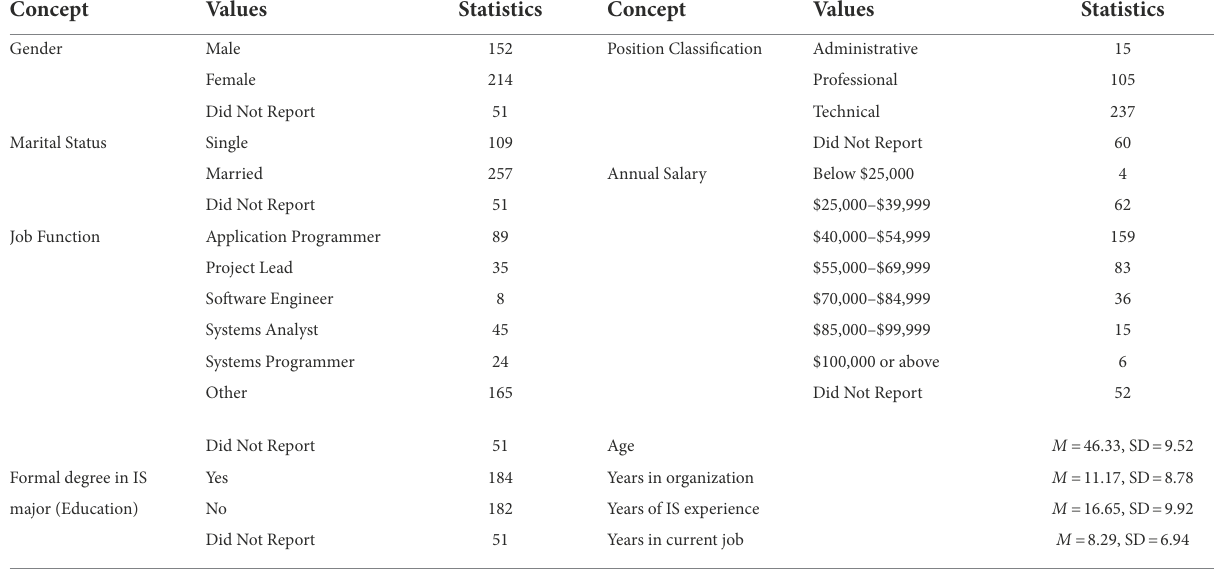
TABLE 1 Demographics for survey